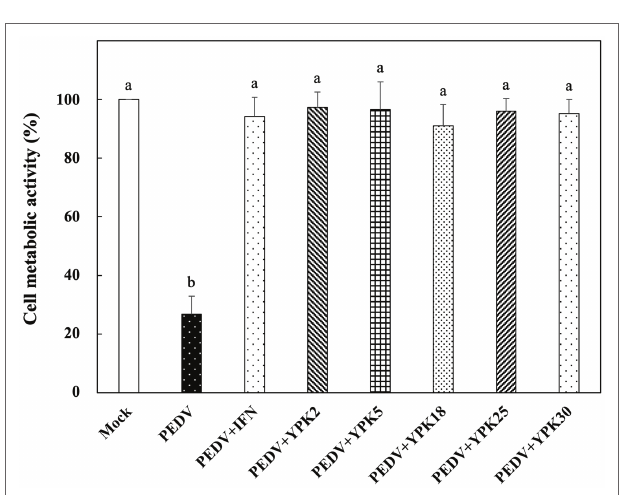
FIGURE 3 | In vitro prophylactic effects of intracellular extracts of different Ln. mesenteroides strains isolated from kefir grains against PEDV infection in Vero cells. Bar chart showing percentage of cell metabolic activity of eight sample conditions: (1) Mock: cells pretreated with PBS and then mock-infected with PBS, (2) PEDV: cells pretreated with PBS and then infected with PEDV, (3) PEDV+IFN: cells pretreated with IFN- α 2b and then infected with PEDV, (4) PEDV+YPK2, (5) PEDV+YPK5, (6) PEDV+YPK18, (7) PEDV+YPK25, and (8) PEDV+YPK30: cells pretreated with the intracellular extracts